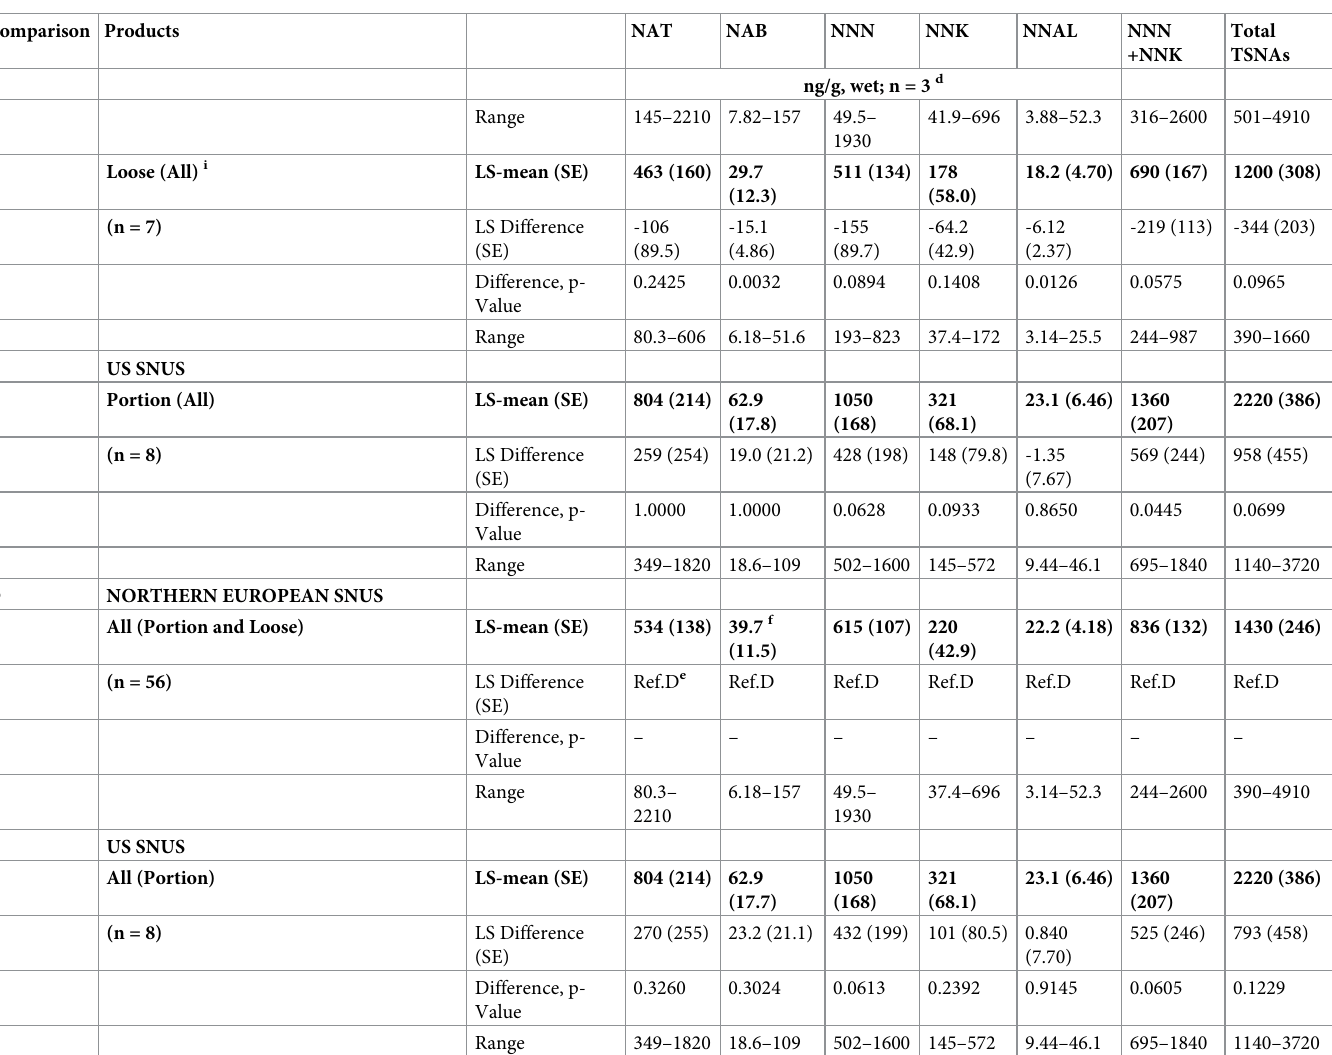
Table 2. Differences in means are evaluated in four comparisons with: A) Northern European portion standard snus; B) Northern European portion white snus; C) Northern European portion snus; and D) Northern European portion and loose